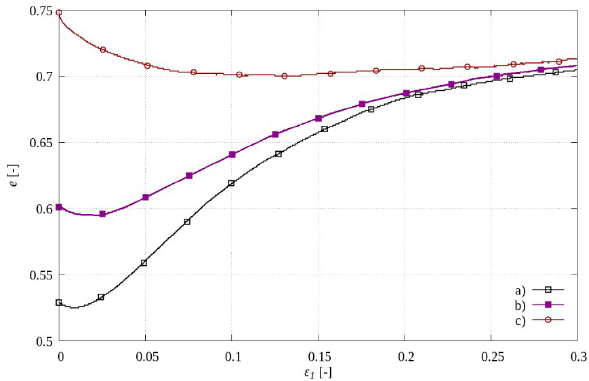
from discrete 1 = 0.75 (σ = 0 0